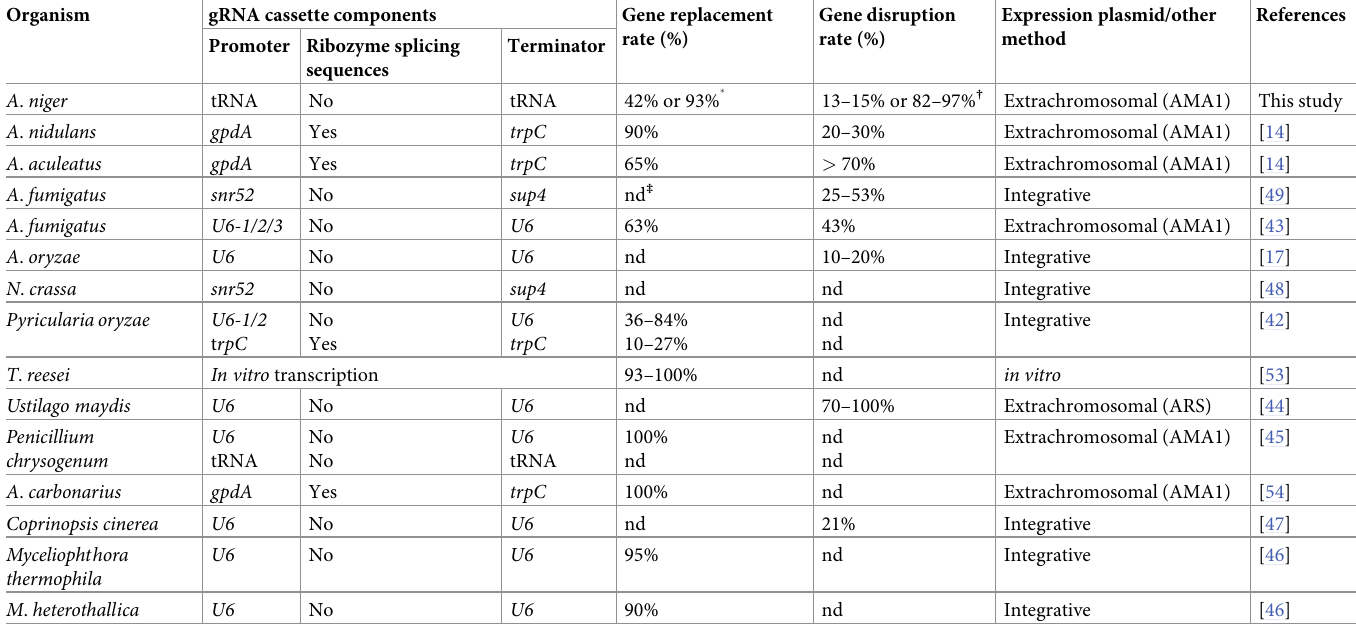
Table 6. Summary of CRISPR/Cas9-mediated gene mutation and replacement efficiencies in filamentous fungi. Organism gRNA cassette